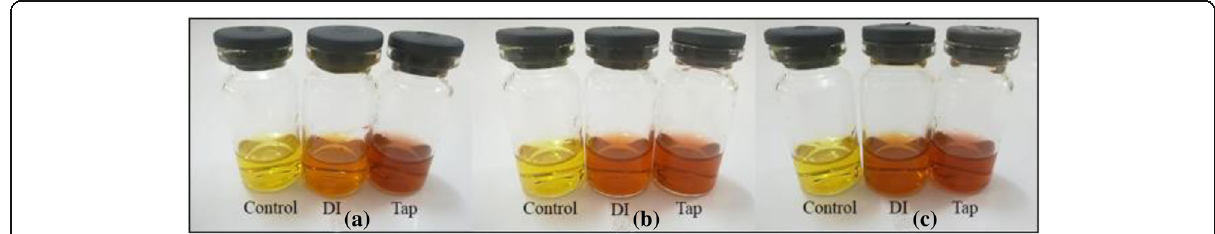
Fig. 10 Silver nanoparticle solution upon addition of ( a ) 1.1 mM, ( b ) 1.2 mM, and ( c ) 1.6 mM of Ni 2+ in distilled water (DI) and tap